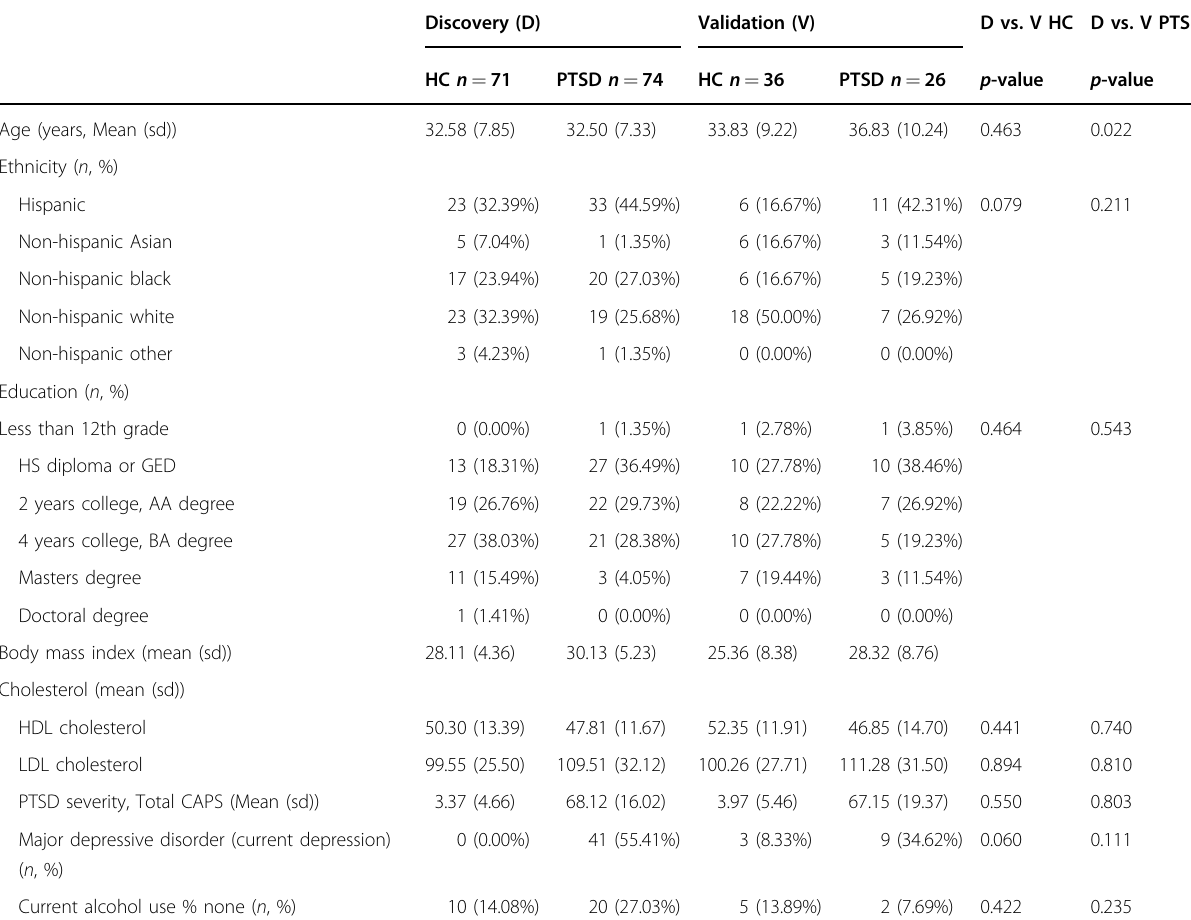
Table 1 Comparison of HC and PTSD cases in discovery (D) and validation (V)